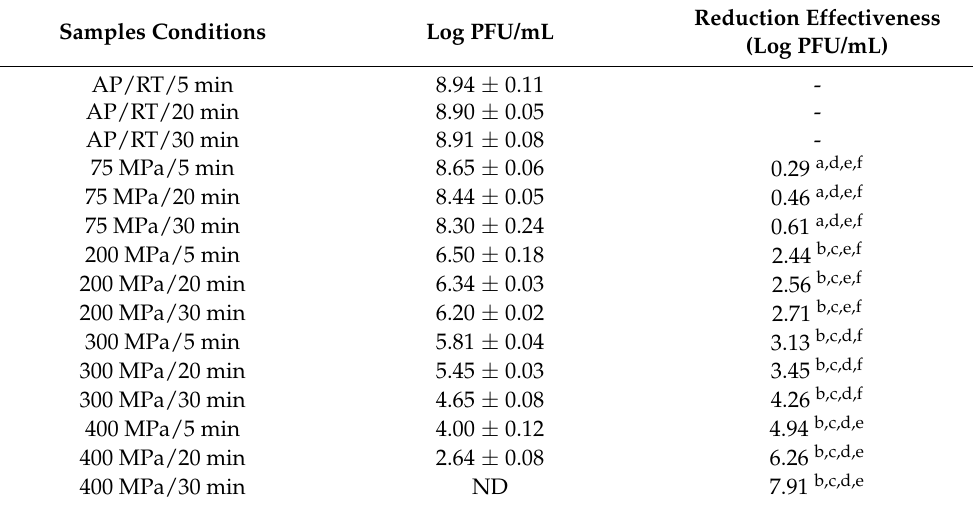
Figure 2. Effect of hydrostatic pressure (75, 200, 300 and 400 MPa) on phage phT4A viability. AP/RT, atmospheric pressure room temperature. Table 1. Reduction in phage phT4A after different hydrostatic pressure